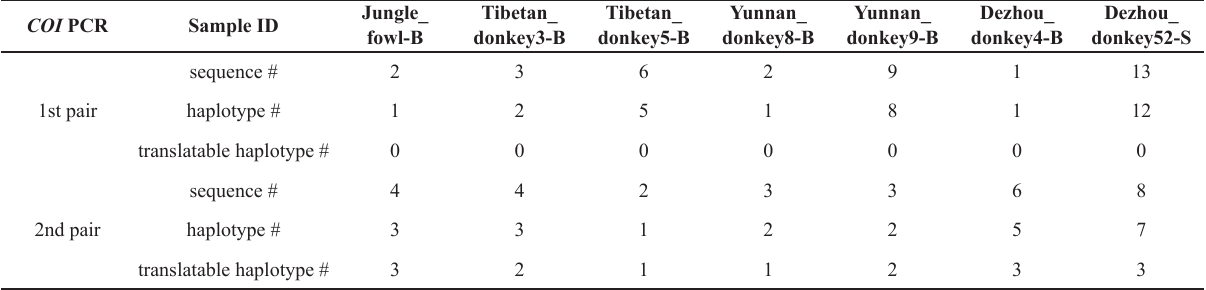
Table 3. COI sequences and haplotypes obtained from the same samples using two pairs of PCR